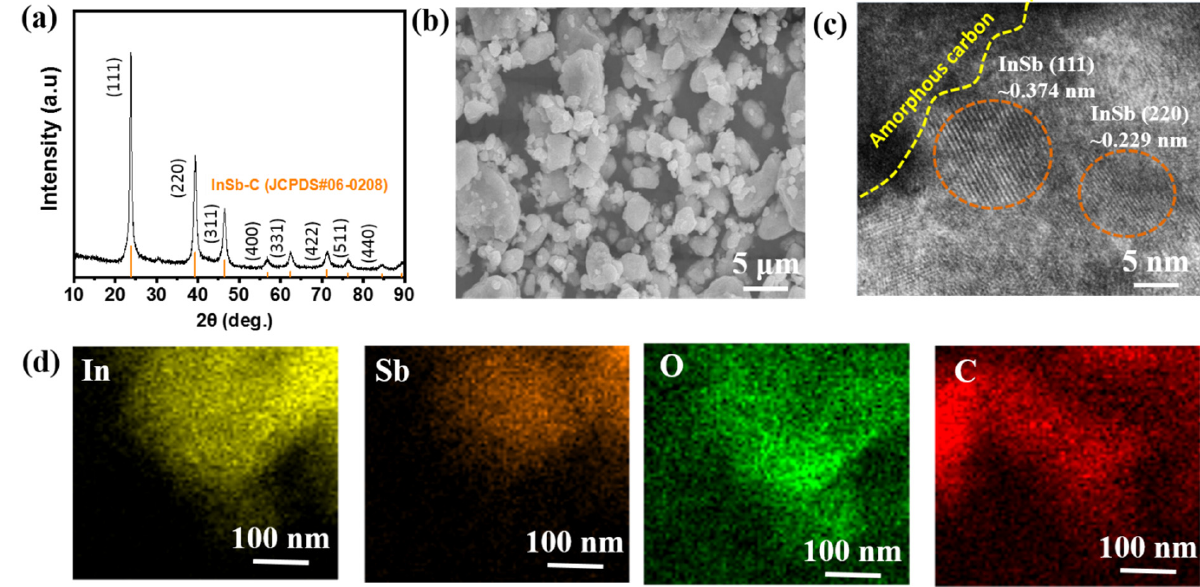
Figure 5. ( a ) XRD pattern, ( b ) SEM image, ( c ) HRTEM image, and ( d ) EDX elemental maps of In, Sb, O, and C of InSb–C.